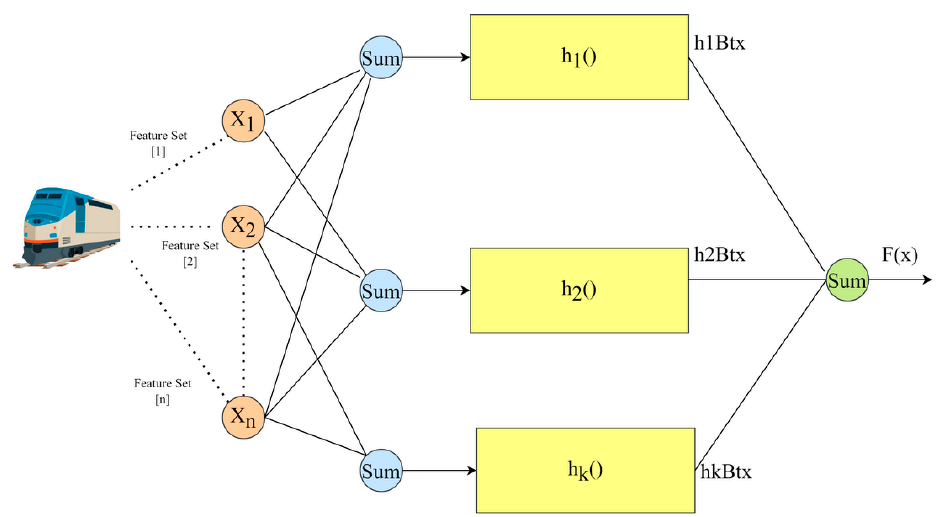
Figure 6. Architecture of the Extended Neural Network.